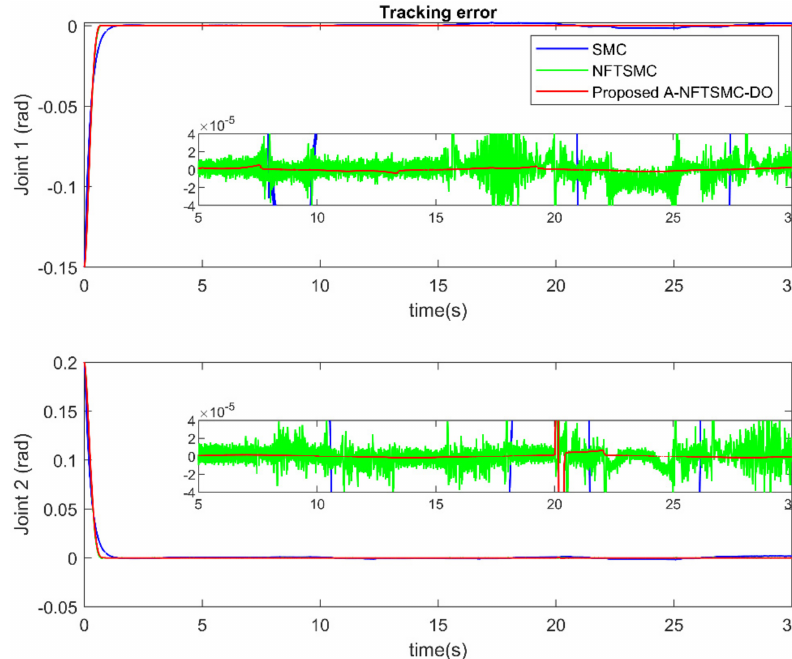
Figure 6. Tracking error at each